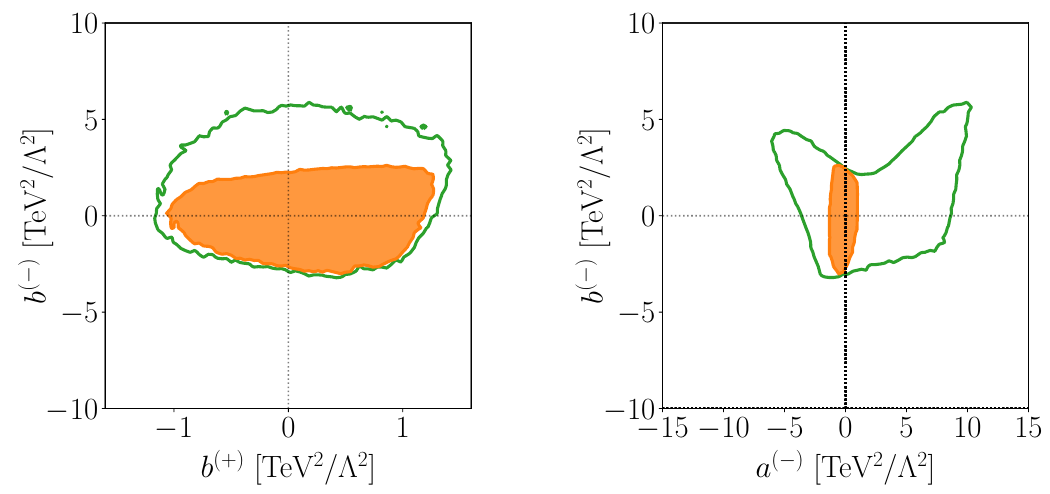
Figure 7 . Bounds on flavor breaking in two-quark couplings, parametrized by b (+) , b ( − ) . Shown are likelihood contours of ∆ χ 2 = 5 . 99 for data set 2 (top+flavor+dijets, green) and data set 3 (including Z − pole data, orange). Left: weak gauge structure of flavor-breaking contributions. Right: flavor- universal versus flavor-breaking couplings. The flavor parameters are defined at µ